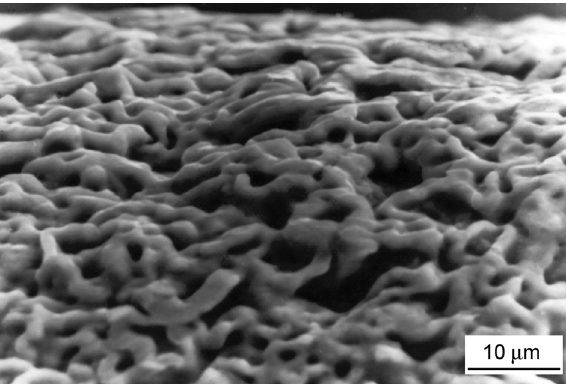
Figure 5: A view of the aluminide coating ( T ¼ 1,050 °C, t ¼ 8 h, p ¼ 150